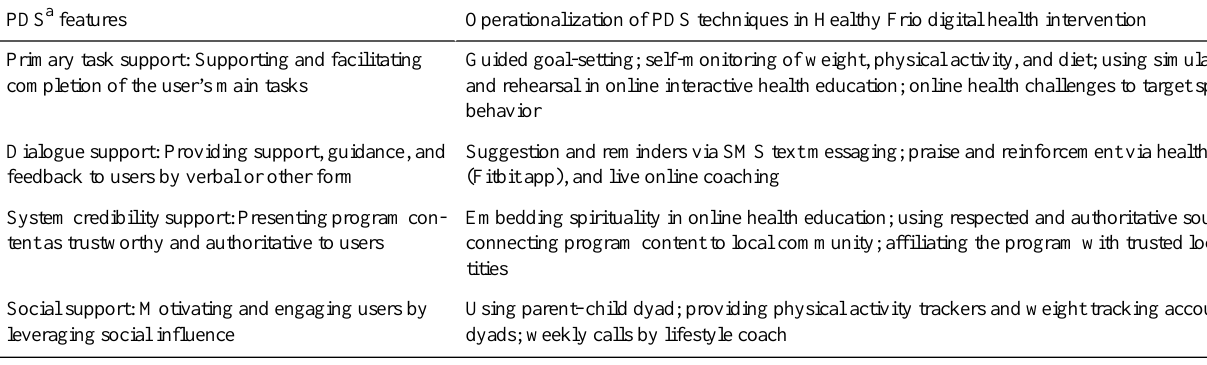
Table 2. Implementation of features and techniques for designing the content and functionality of a persuasive design system.